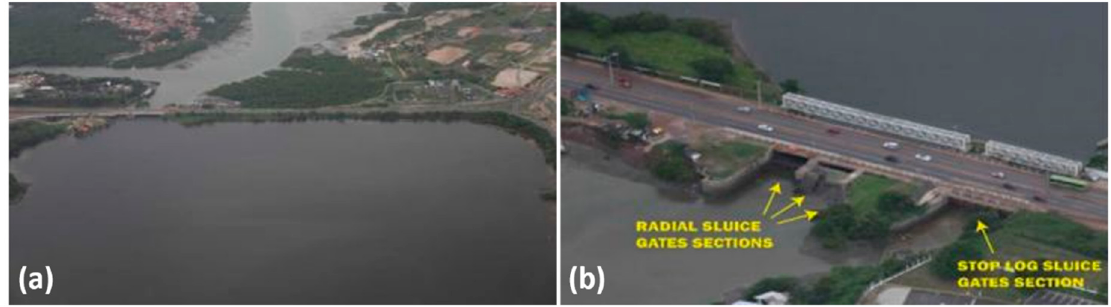
Figure 23. ( a ) The Bacanga Estuary, and ( b ) aerial image of the radial and stop-log sluice gates [192].